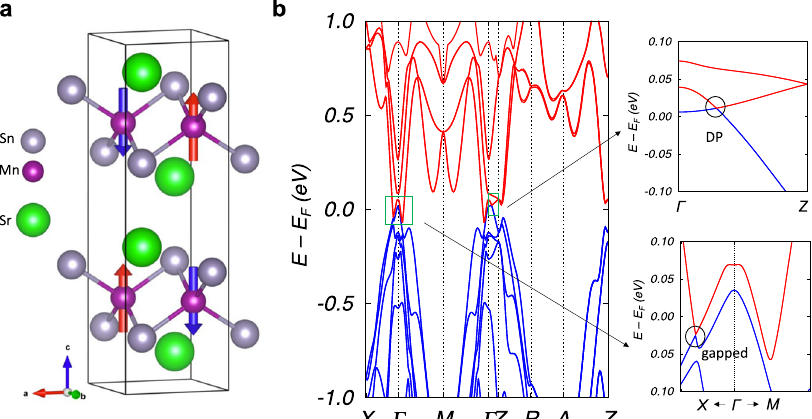
Fig. 3 Magnetic Dirac nodal loop semimetal mp-20759 SrMnSn. a Crystal and AFM structure of SrMnSn. b The electronic structure of SrMnSn displays a symmetry-protected Dirac point along Γ -Z, and a symmetry-enforced Dirac nodal loop along